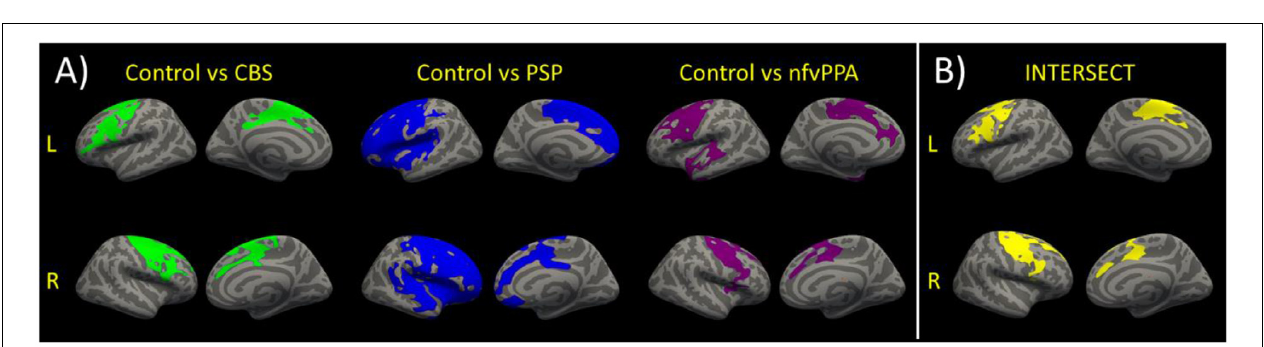
regions. The overlap between each patient-control cluster and the intersect of the three patient-control analyses clusters to